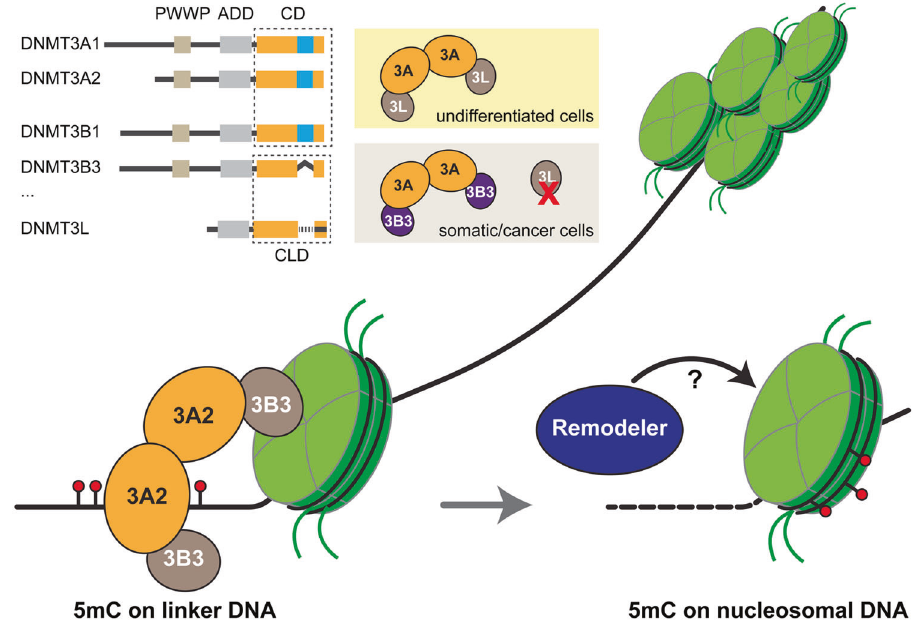
Fig. 1 DNA methylation by a spliced DNMT3A2-3B3 complex on a single